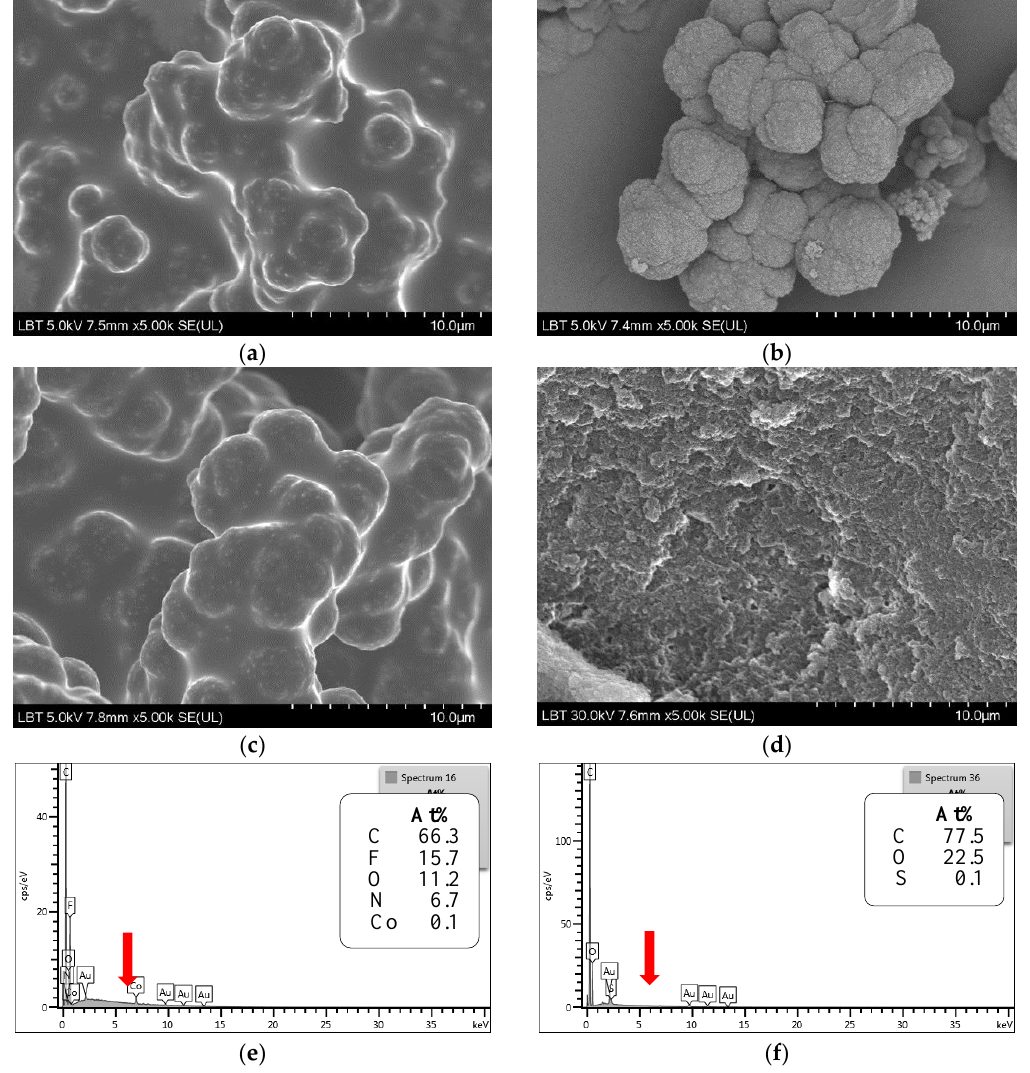
Figure 2. Scanning electronmicrographs of monolithic imprinted polymers of M2 ( a ) before and ( b ) after MeOH:AcOH 9:1( v / v ) washing, ( c ) M8 and ( d ) M5 before MeOH:AcOH 9:1( v / v ) washing. Elemental mapping spectrum of M2 ( e ) before and ( f ) after template removal indicating the washout of the metal pivot ion (Co(II)).